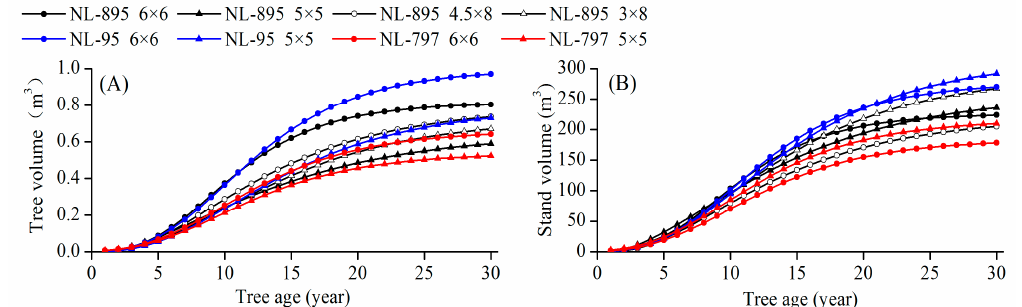
Figure 5. Predictions of tree volume ( A ) and stand volume ( B ) in different treatments of poplar clones and planting spacings by the fitted Chapman–Richards model (up to 30 years).